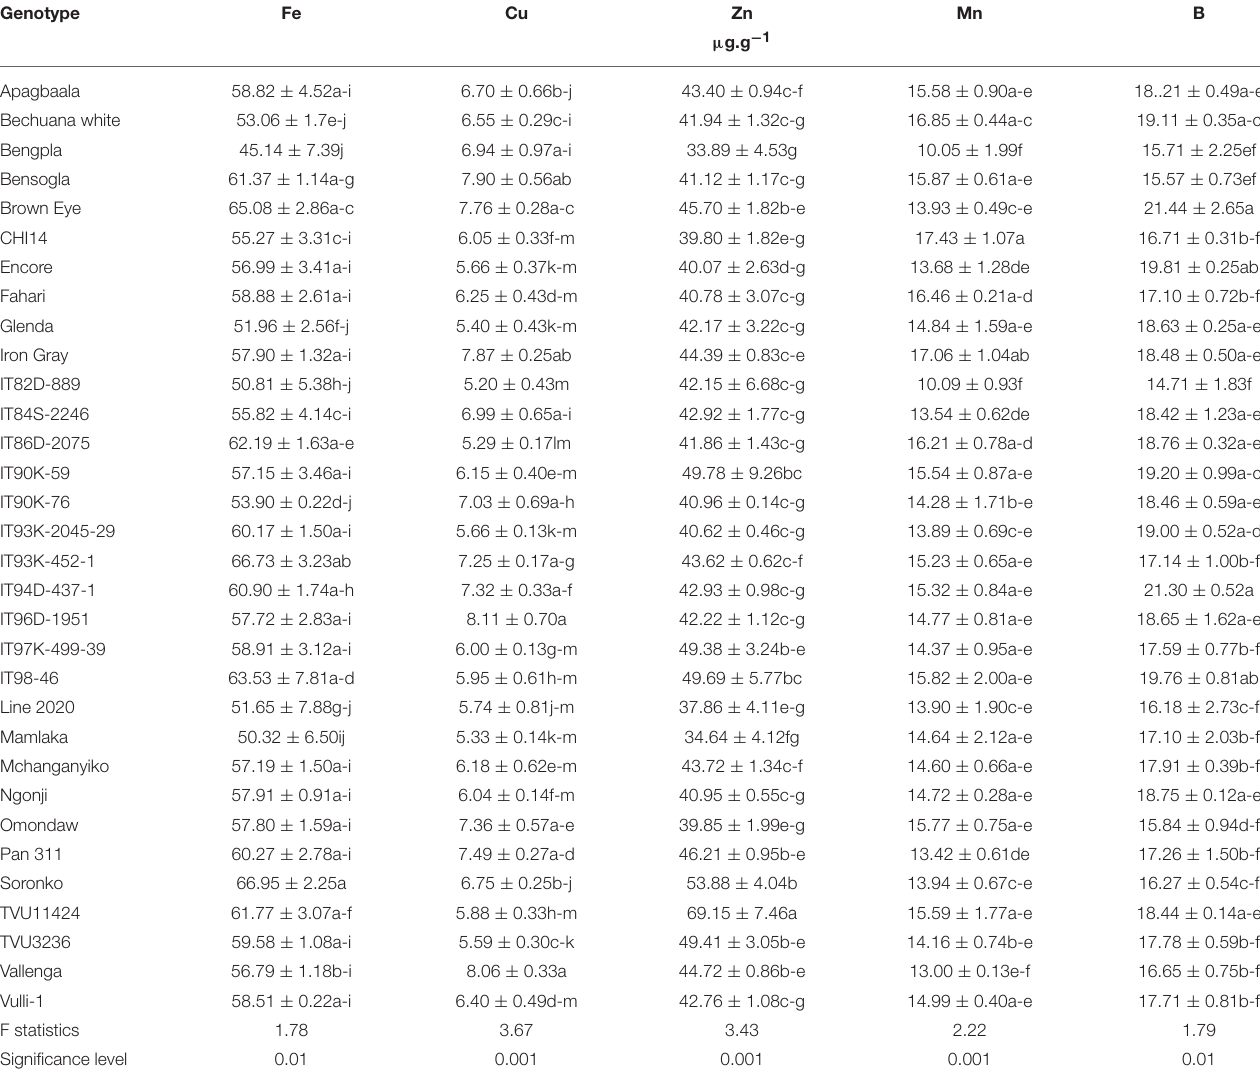
TABLE 2 | Micronutrients in seed of field-grown cowpea varieties harvested at 150 DAP in Taung.